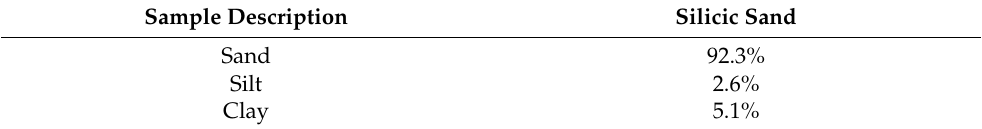
Table A3. Sand description * based on the percentage of sand, silt, and clay in each sample.